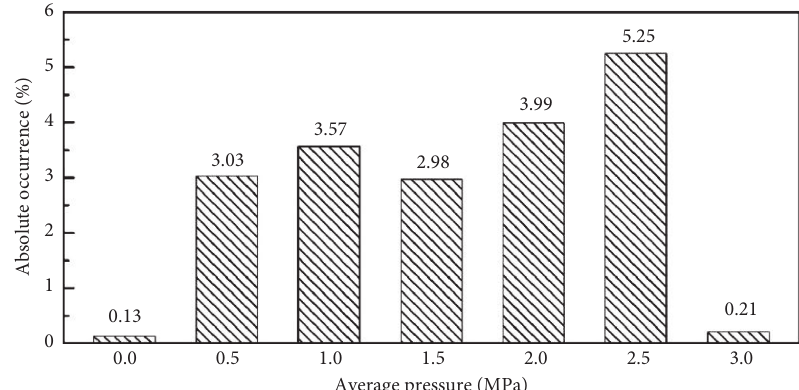
Figure 4: Absolute noise occurrence for different average pressures.